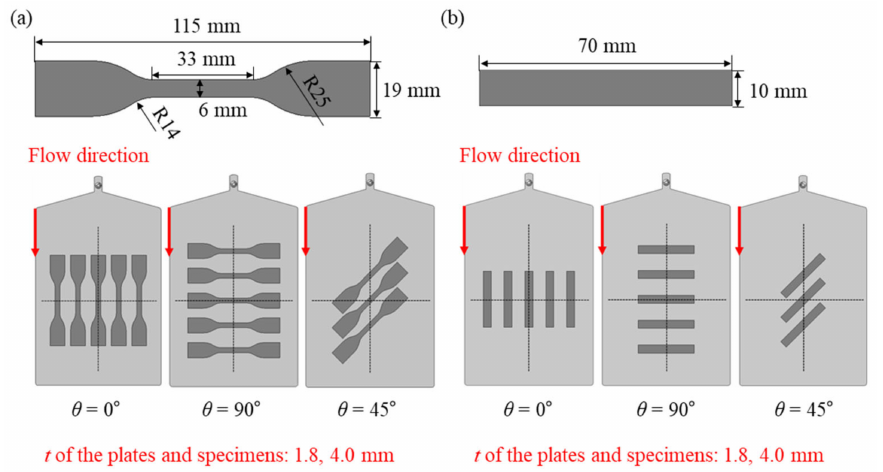
Figure 2. ( a ) ASTM-D 638-02a-Type IV specimen dimensions and cutting location of the tensile specimens from the plate, ( b ) ASTM-D3410M-16 specimen dimensions and cutting location of the compressive specimens from the